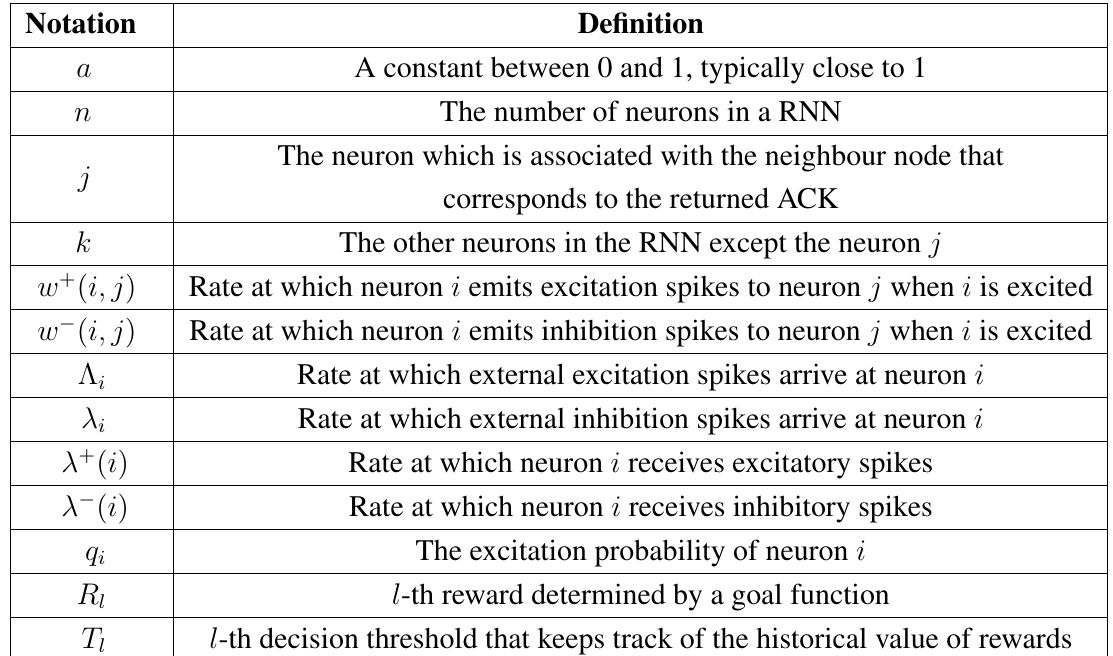
Table 1. List of symbols used in Pseudocode 1. RNN, random neural